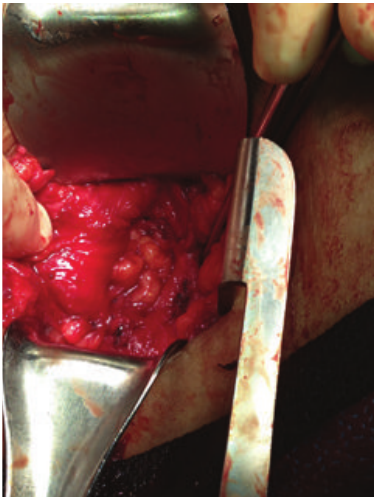
Figure 7: Approximation of muscle fascia on top of the